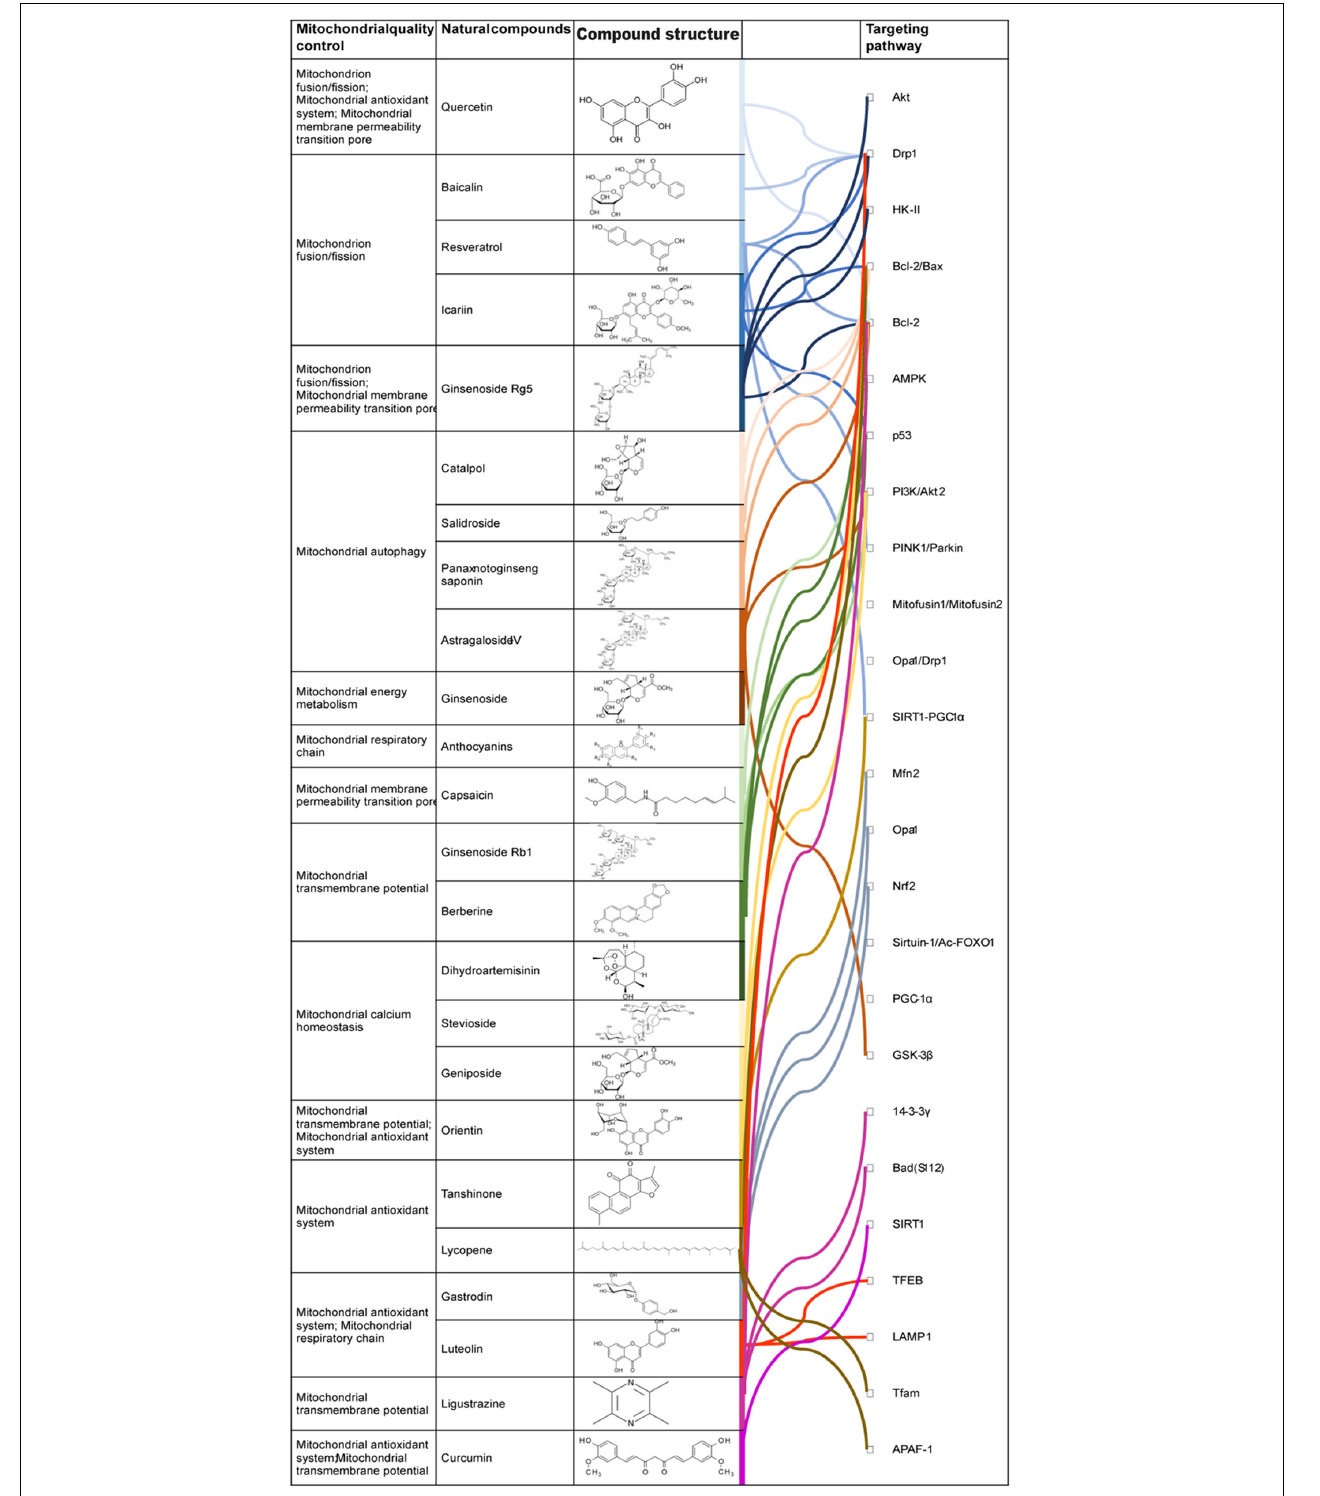
FIGURE 2 | Regulationmechanism of Natural drugs in MQC. Active ingredients in natural drugs can influence the production of energy-supplying substances in the mitochondria, interfere with the expression of genes associated with mitochondrial energy requirements, and regulate various mechanisms of MQC modulation.